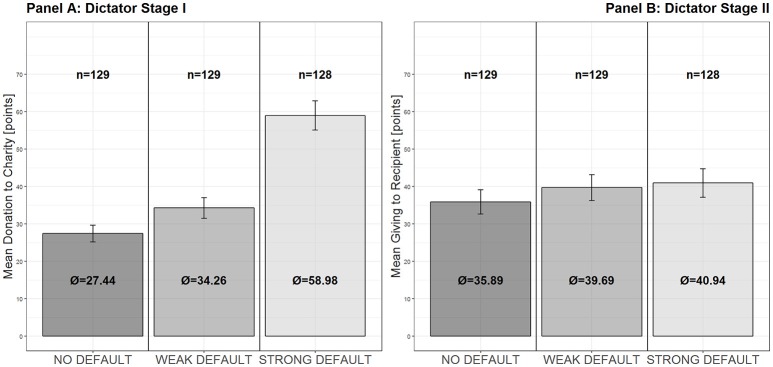
Choices in Dictator Stage I and II. Panel (A) Shows giving decisions (mean points donated to charities) in Dictator Stage I for NO DEFAULT, WEAK DEFAULT and STRONG DEFAULT. Panel (B) Shows mean giving (points given to recipient) in the Dictator Stage II for the three treatment conditions. Error-bars denote plus/minus one standard error of the mean.